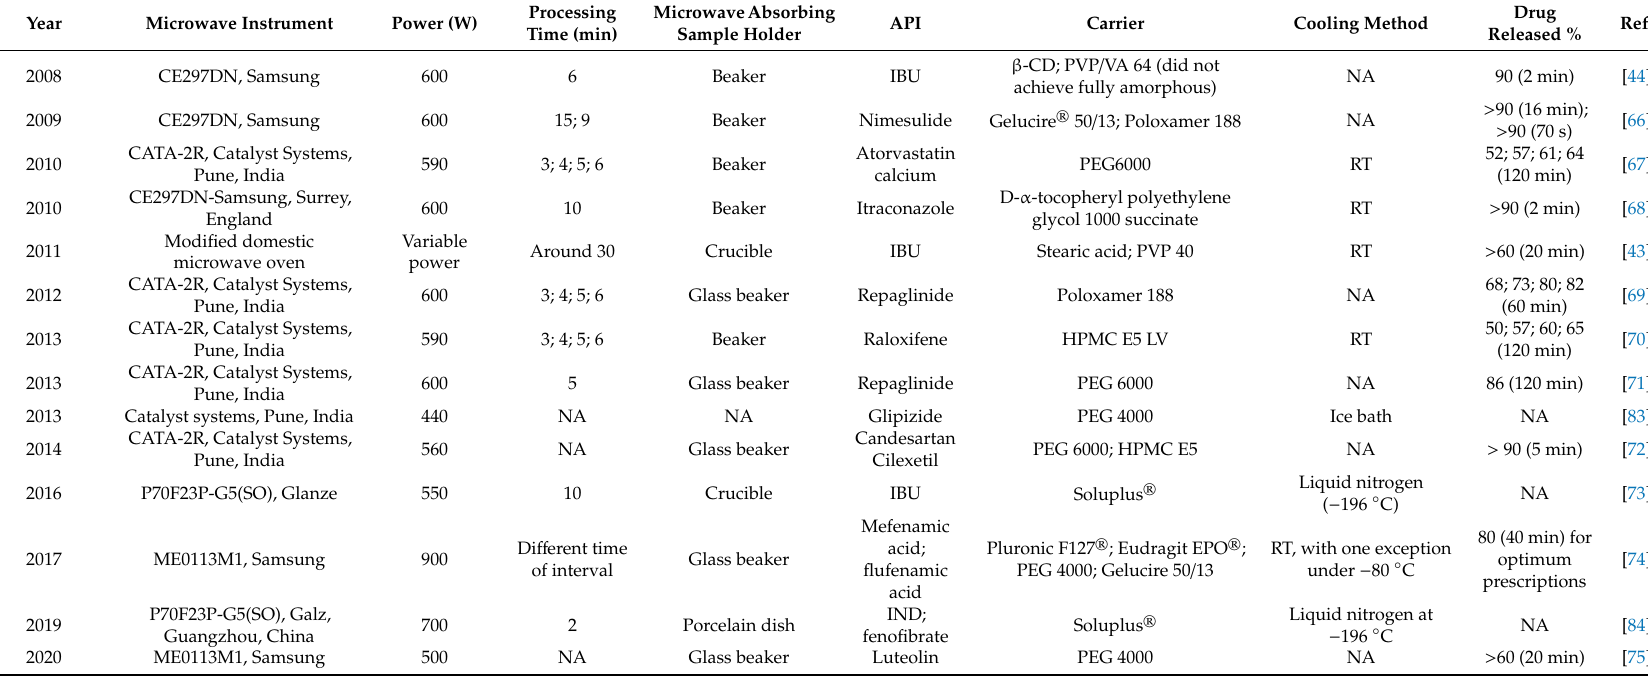
Table 2. Summary of publications on the application of microwave heating in the preparation of bulk amorphous solid dispersion (ASD)